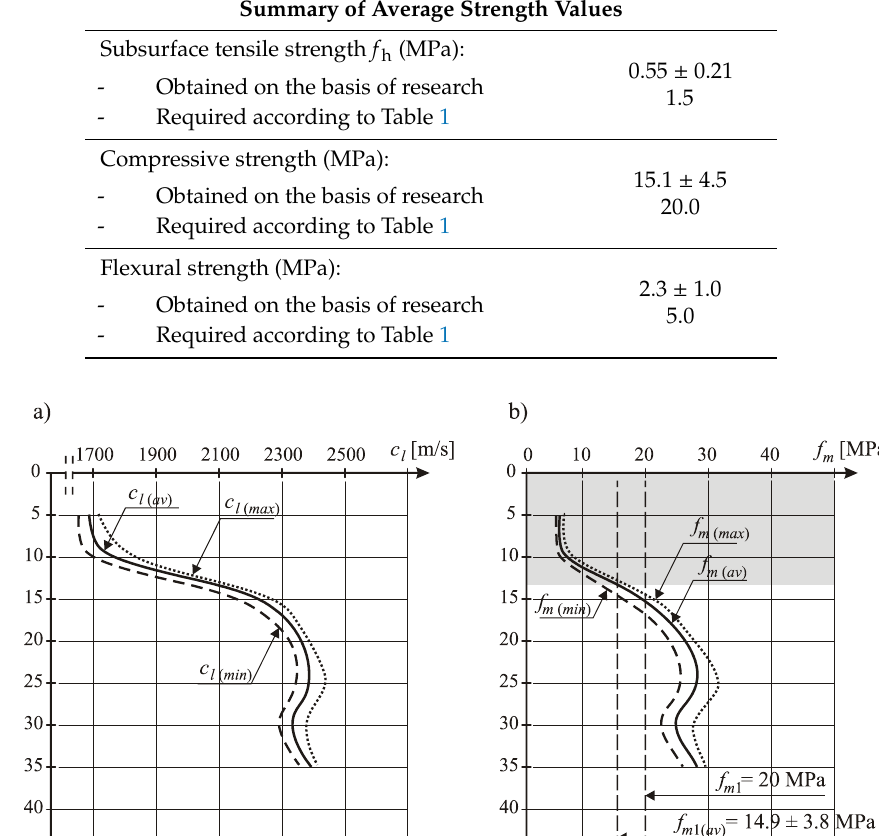
Table 2. Sample results of strength tests carried out for one of the cement floors tested in accordance with [46] (own study based on the data provided [25]) .